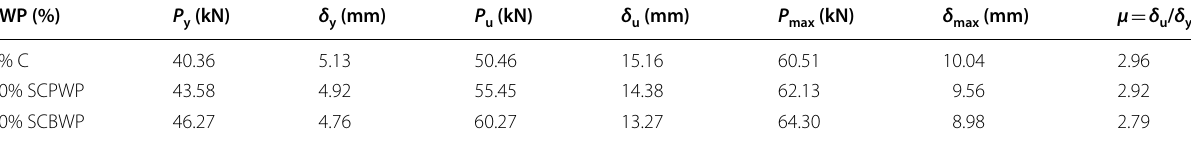
Table 5 Load–deflection values (SS